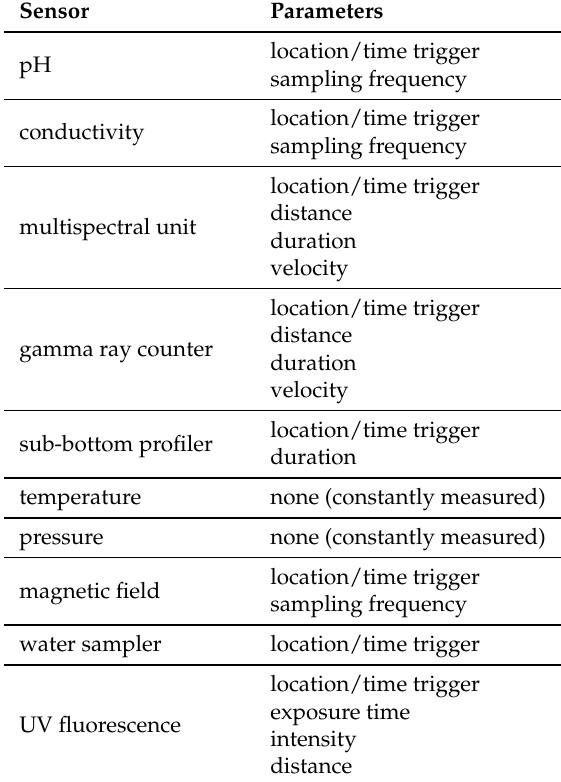
Table 2. Scientific